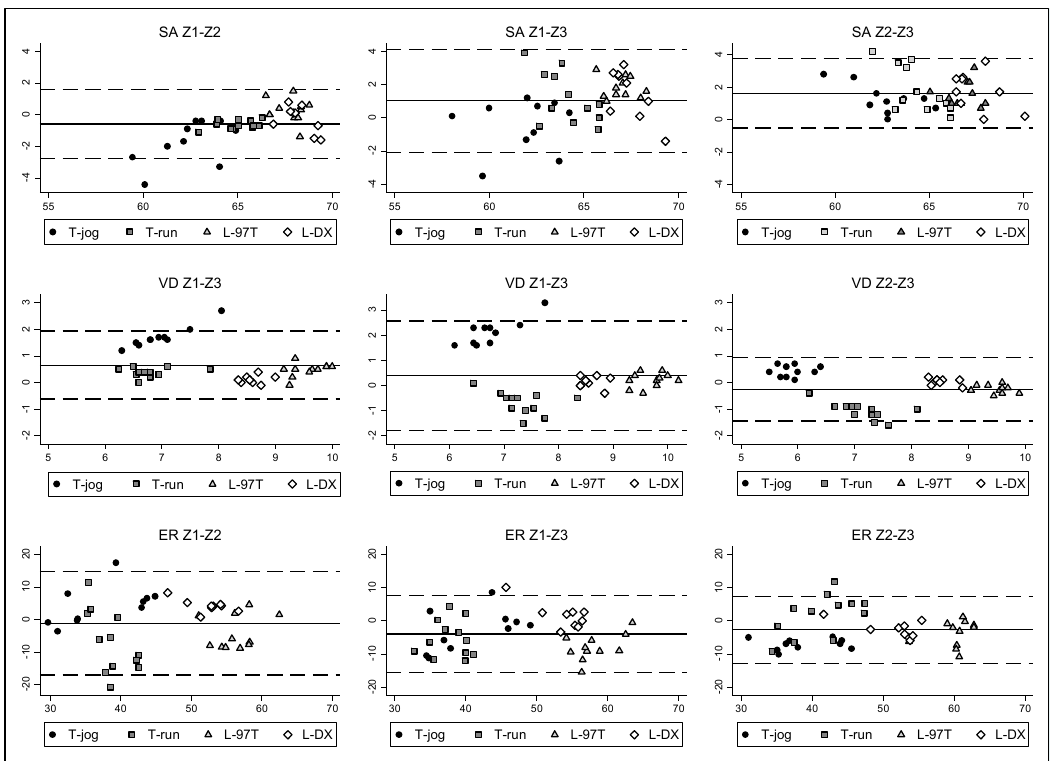
Figure 4. Bland–Altman analysis of the agreement between the di ff erent zones. The x -axis represents